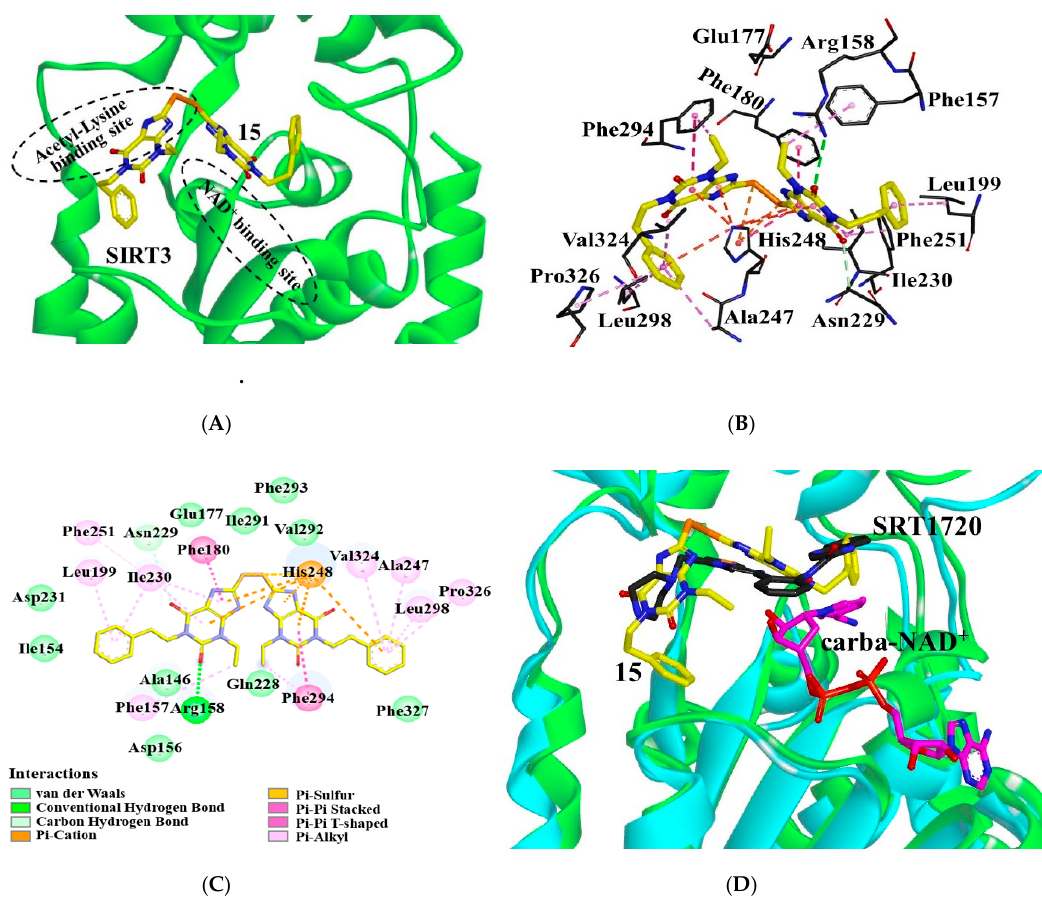
Figure 3. Interactions of compound 15 with SIRT3. ( A ) Binding site of 15 (yellow) in SIRT3. ( B ) 15 (yellow) interacts with the residues composed of the acetyl lysine binding site. Dotted lines in different colors represent various interactions (hydrogen-bond in green, π – π interaction in purple, π –cation, and π –sulfur interactions in orange, and CH– π interaction in pink). ( C ) Interaction details of 15 with SIRT3. ( D ) Binding modes of 15 or SRT1720 in SIRT3: SIRT3 (green) with 15 (yellow), SIRT3 (cyan) / SRT1720 (black) / carba-NAD + (magenta) (pdb ID: 4BN5). Images were generated with PyMol. According to the binding mode, the R1 substituent of 15 is surrounded by hydrophobic residues of Leu199, Ile230, Ala247, Leu298, Val324, and Pro326. Improvement of the hydrophobicity of R1